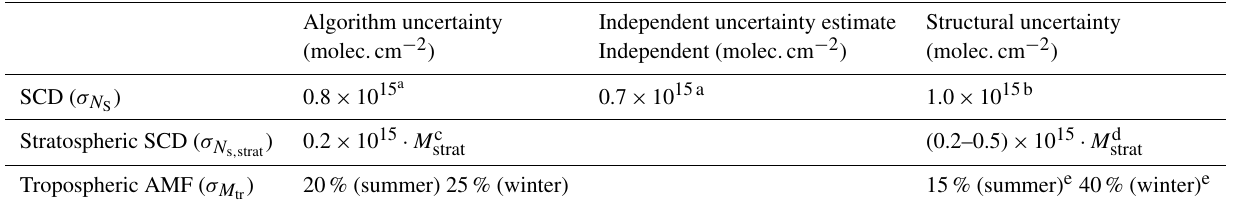
Table 6. Comparison of uncertainty estimates for the main QA4ECV OMI NO 2 retrieval steps. The SCD and stratospheric SCD uncertainties are representative of all possible retrieval scenarios. AMF uncertainties are representative of situations with high NO 2 .